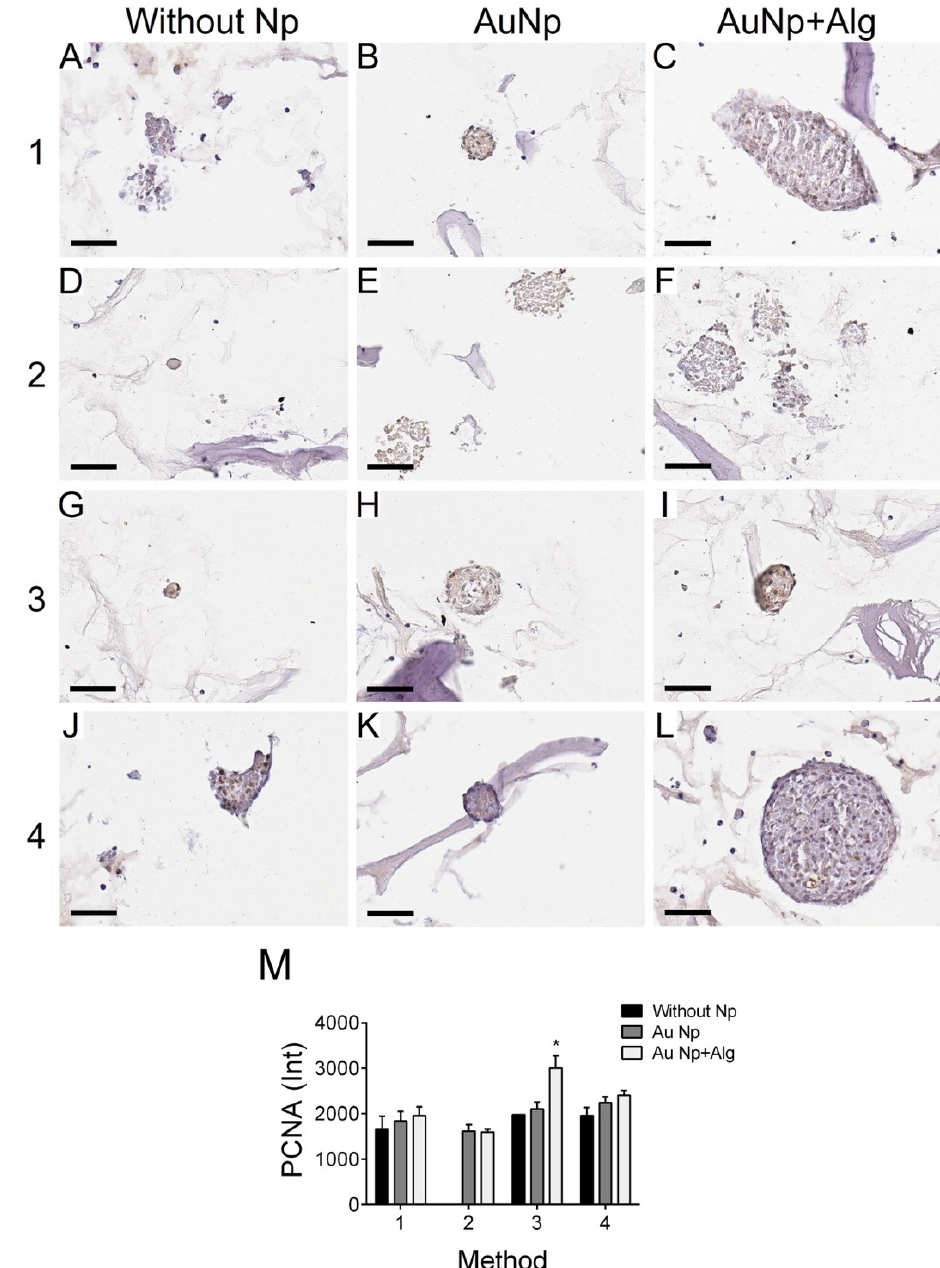
Figure 7. Representative photomicrographs of PCNA expression in different constructs. Method 1: ( A ) without Np, ( B ) AuNp and ( C ) AuNp+Alg. Method 2: ( D ) without Np, ( E ) AuNp and ( F ) AuNp+Alg. Method 3: ( G ) without Np, ( H ) AuNp and ( I ) AuNp+Alg. Method 4: ( J ) without Np, ( K ) AuNp and ( L ) AuNp+Alg. Scale bar: 50 µm, original magnification: ×400. ( M ) Graphical representation of the quantitative analysis of PCNA expression (Int) in the different constructs. (*) p < 0.001. Data are presented as the mean ± SE.